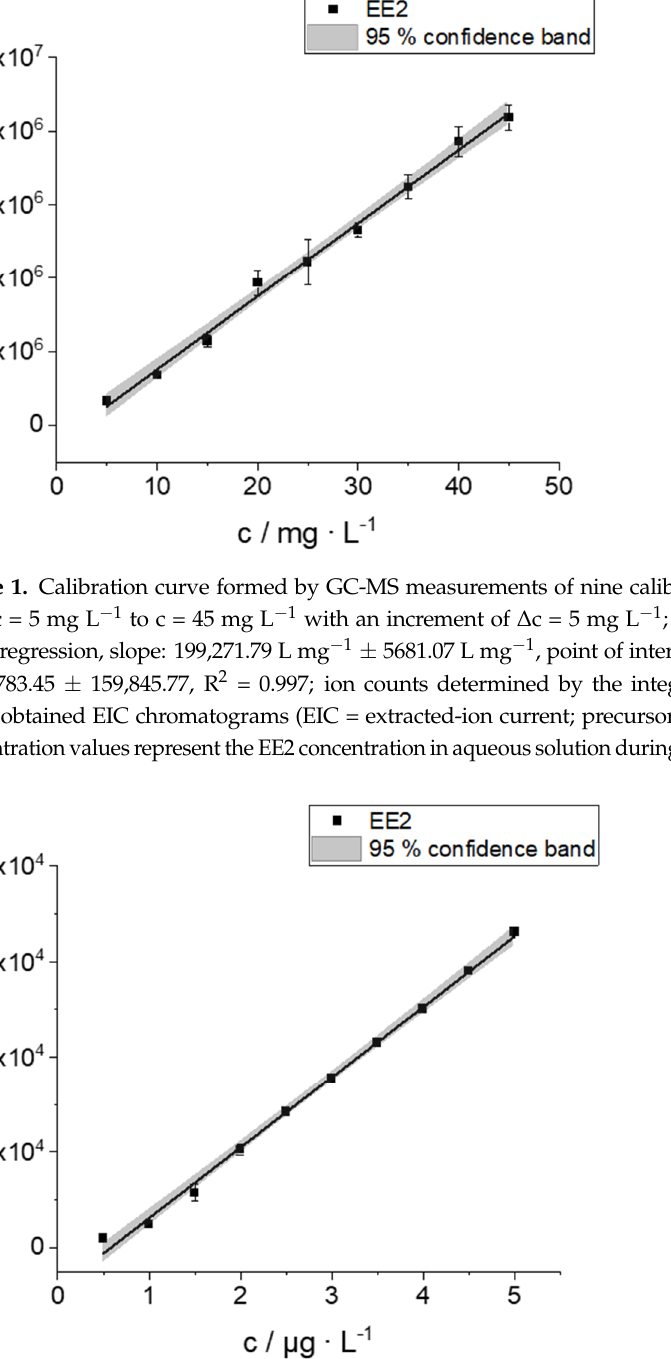
Figure 2. Calibration curve formed by UHPLC ‐ MS/MS measurements of ten calibration standards ranging from c = 0.5 μ g L − 1 to c = 5 μ g L − 1 with an increment of ∆ c = 0.5 μ g L − 1 ; quintuple determination; linear regression, slope: 14,771.11 ± 325.04 L μ g − 1 , point of intersection with the ordinate: − 8580.63 ± 1008.42, R 2 = 0.998; ion counts determined by the integration of the respective EE2 signal in the obtained TIC chromatograms of MRMs (TIC = total ‐ ion current; see Section 4.2.8. UHPLC ‐ MS/MS Analysis“ Table 3 for information on the precursor ion); the concentration values given represent the EE2 concentrations in aqueous solution during the catalytic experiments.